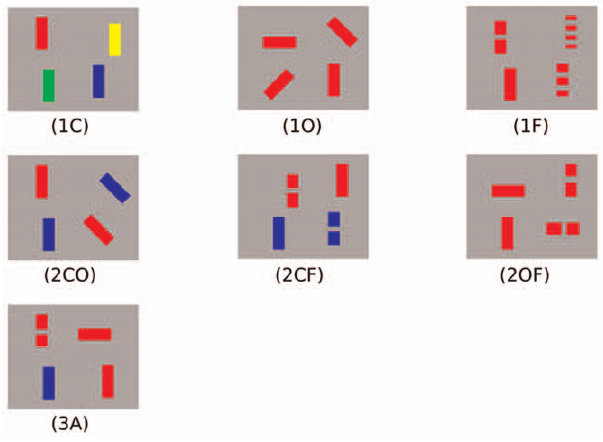
Figure 1. Example displays. Example display sets for each arity- dimension condition. In each case, the target is the (red, 90, 0-gap) object.